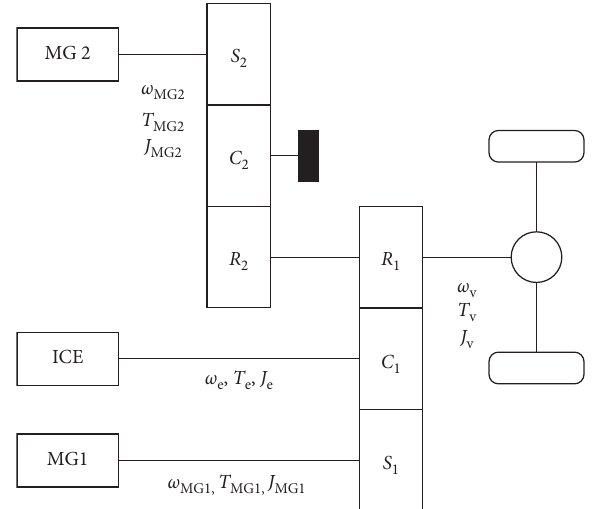
Figure 2: Power transmission of coupling